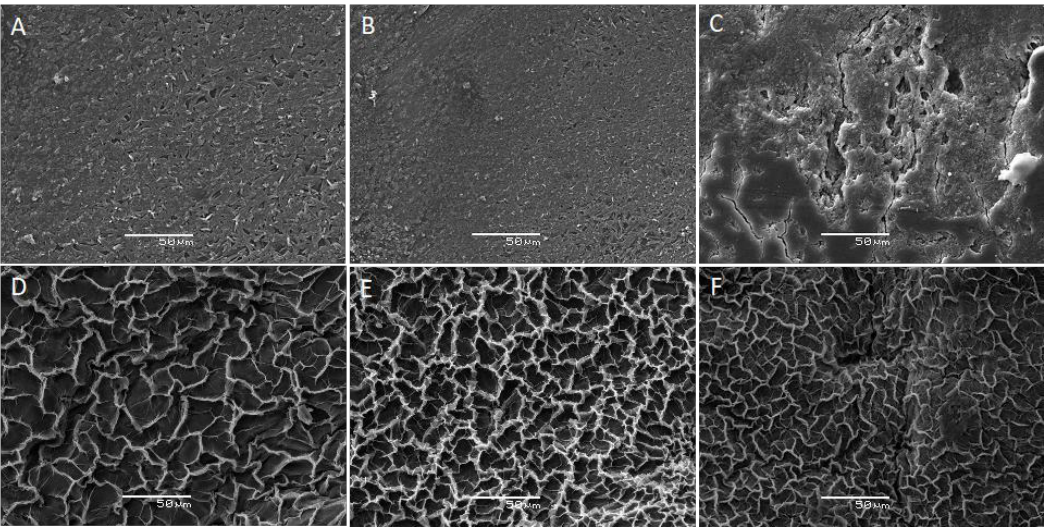
Figure 7. SEM images of ( A ) PMALH10, ( B ) PMALH20, ( C ) PMALH30 hydrogels, ( D ) PMALH10-AgNPs, ( E ) PMALH20-AgNPs, and ( F ) PMALH30-AgNPs nanohybrids.